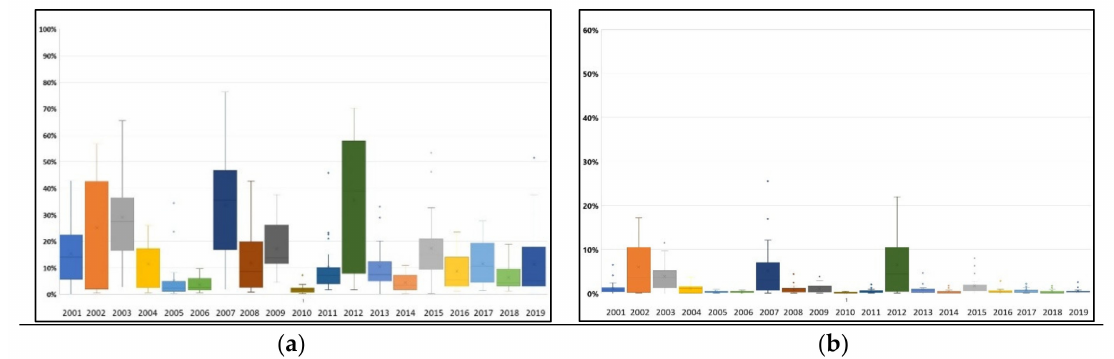
Figure 7. Box-plot type diagram of agriculture areas a ff ected: ( a ) by drought with di ff erent intensities according DSI; ( b ) by extreme drought according DSI, between 2001 and 2019 in Romania. The number of samples for 2001 is 21 and for the other years is 23.